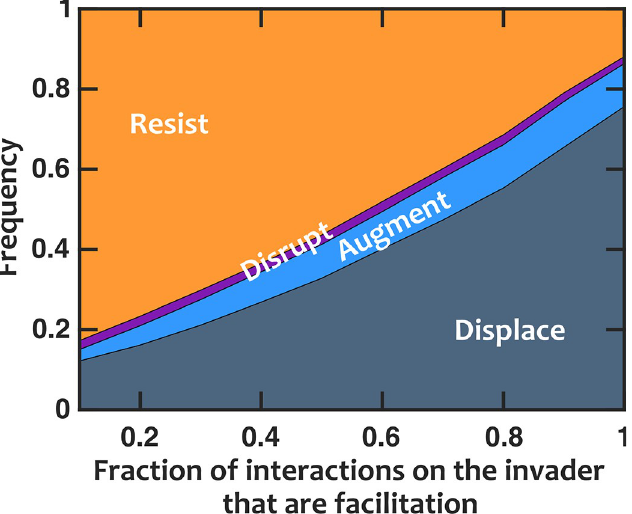
Fig 3. When resident species facilitate the invader, colonization resistance is weakened. Invasion success drastically increases when we switch the interactions that influence the invader from inhibition to facilitation. Number of instances examined N s = 1000. Interactions among resident members are equally likely to be facilitative or inhibitory 0.5). Normalized basal growth rate of the invader is 1.5. Normalized introduced propagule size is ( f fac =